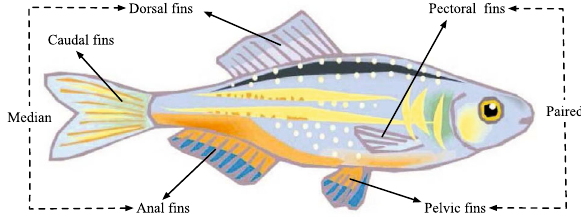
Fig. 1 Terminology related to the fish of Carangiform